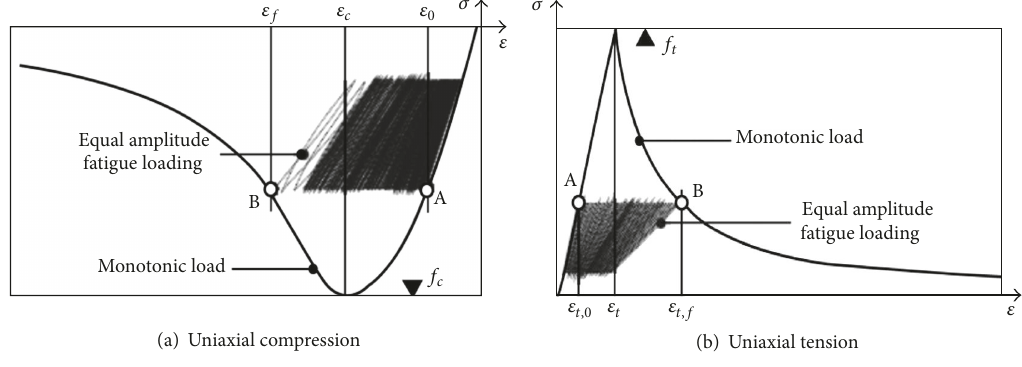
Figure 1: The concrete uniaxial static load and fatigue stress-strain